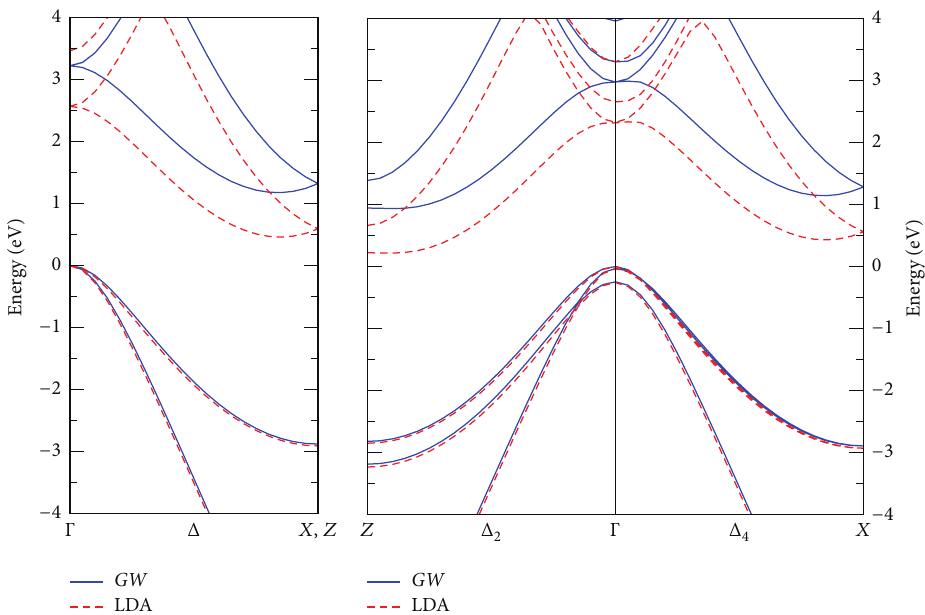
Figure 2: Band structure of Si within DFT-LDA (dashed lines) and 𝐺𝑊 (solid lines) without strain (left) and with 2.5% uniaxial strain in the [110] direction (right). The six originally degenerate conduction-band minima (left panel) split into two lower Δ 2 valleys along the Γ – 𝑍 direction and four higher Δ 4 valleys along the Γ – 𝑋 direction (right panel).